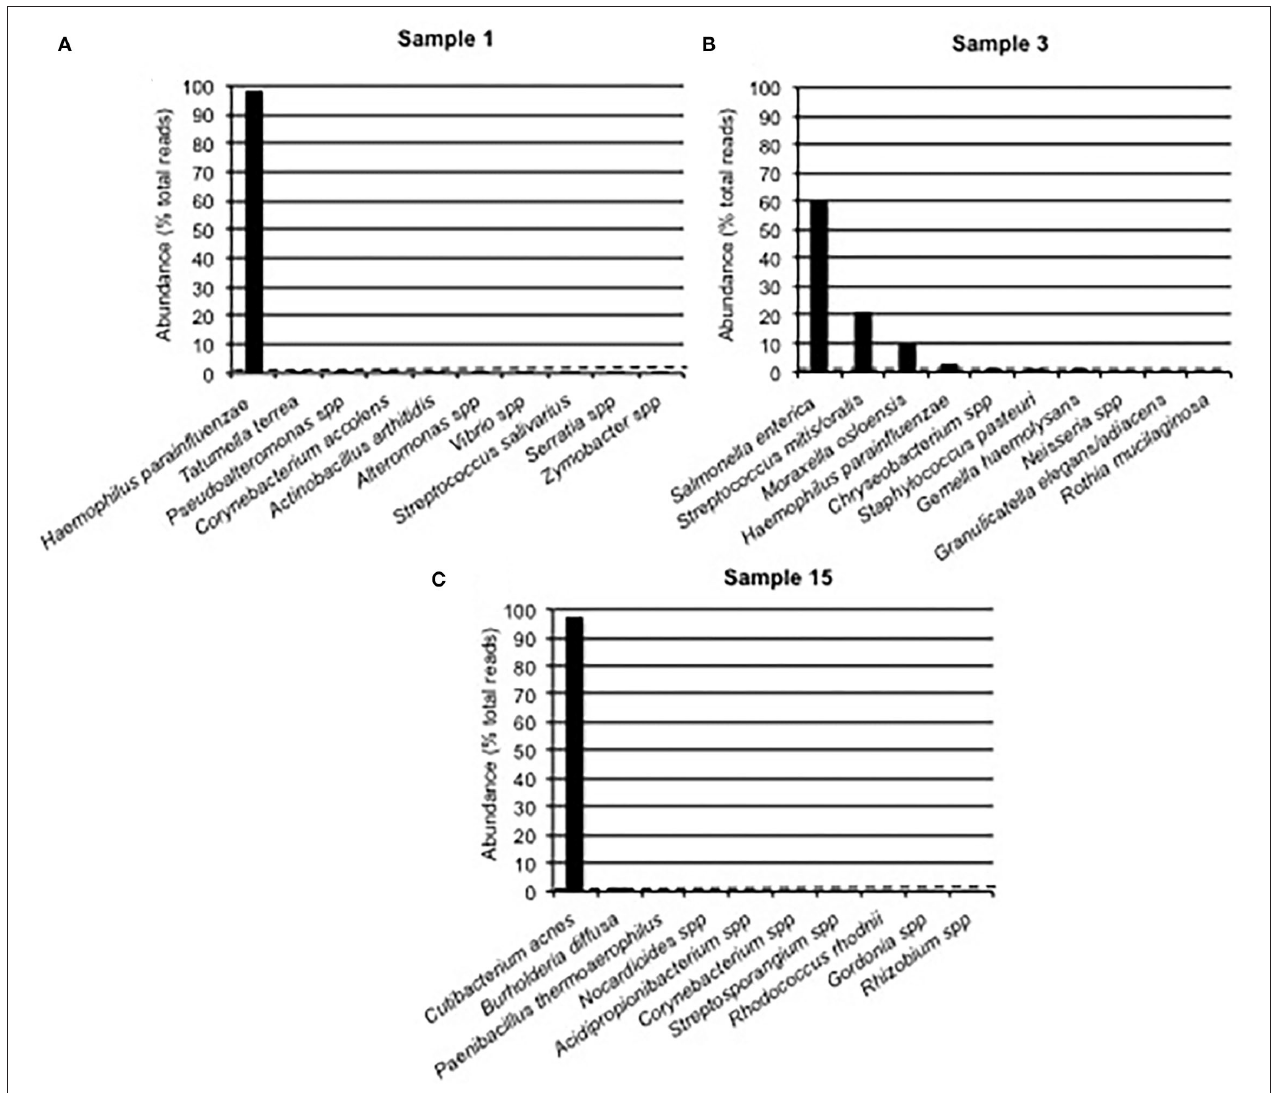
FIGURE 2 | The Bacterial Composition of Clinical Samples Is Based on Nanopore Technology. Examples of Partial 16S Approach Results From Sanger-Based Mono- and Polymicrobial Clinical Samples. An Abundance Histogram Represents the Proportion of Reads Assigned to up to 10 Predominant Bacteria. The Dotted Line Displays the 1% Abundance cut-off. (A) The Presence of one Single Bacterium Above the 1% cut-off, Followed by a Steep Fall Distribution of Other Detected Bacteria, Concluded to a Monomicrobial Sample With Some Background Noise. (B) The Presence of More Than one Bacterium Above the 1% cut-off Concluded to a Polymicrobial Sample, Along With Some Background Noise. (C) Sample 15 Displayed the Presence of 2 Bacteria Above the 1% cut-off, While Their Respective Abundances Were Greatly Different.